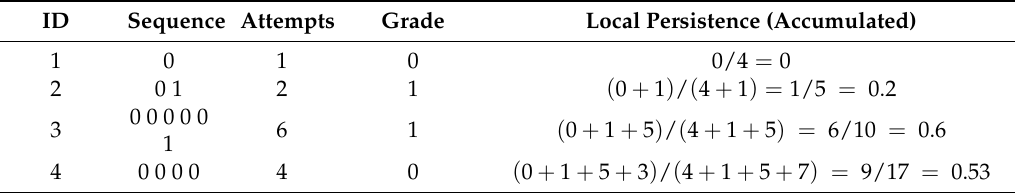
Table 3. Example of computation of local